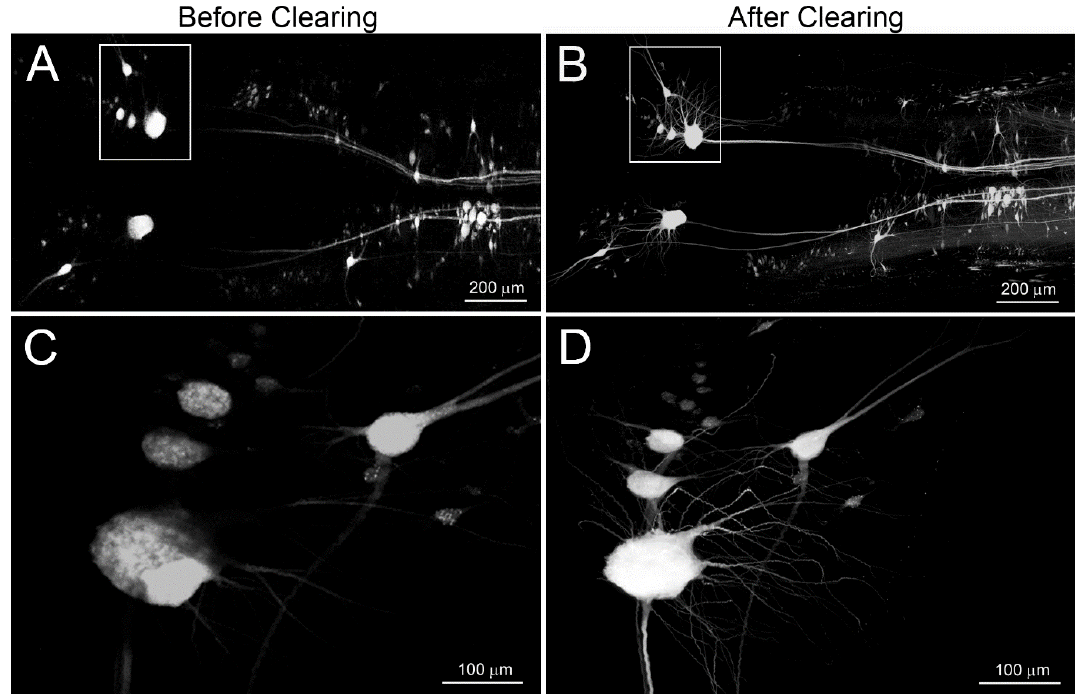
Figure 3. BABB clearing increases resolution of RS neuronal structure in confocal micrographs of brain wholemounts. To compare images between conventional and confocal microscopes, the same sample shown in Figure 1 was imaged with a confocal microscope (Nikon C2) and displayed in the same orientations. ( A , C ) before BABB clearing. ( B , D ) after BABB clearing. Confocal images were captured in 5 µm optical sections and are shown at maximum intensity projection. ( A ) and ( B ) were captured under a 10× objective, and ( C ) and ( D ) under a 20× objective.